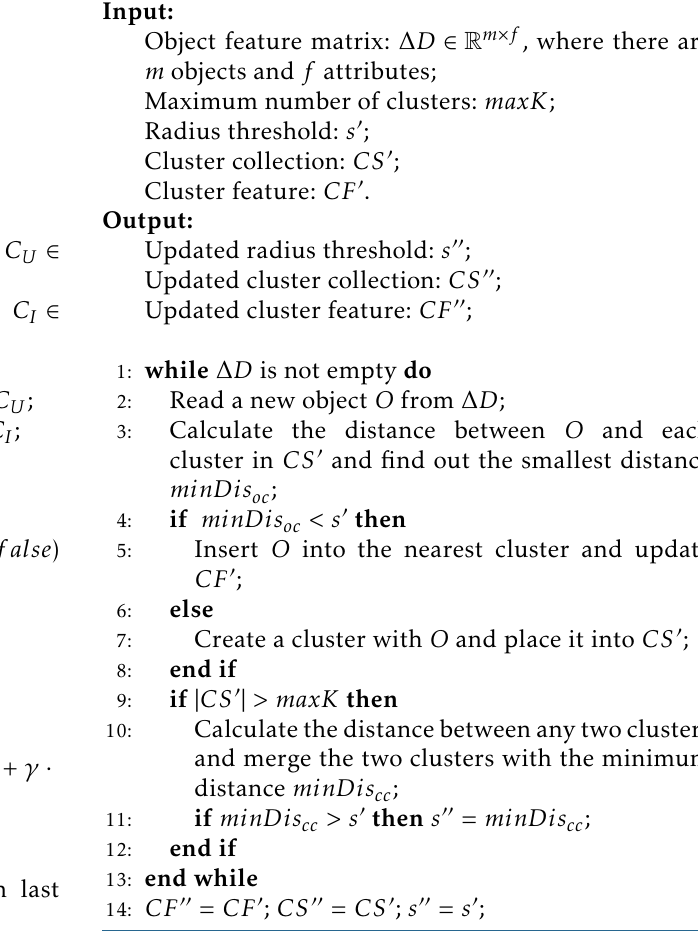
Figure 1. Updating new rows in iCluster-NMF Algorithm 2 Cluster-NMF Algorithm 3 Incremental clustering